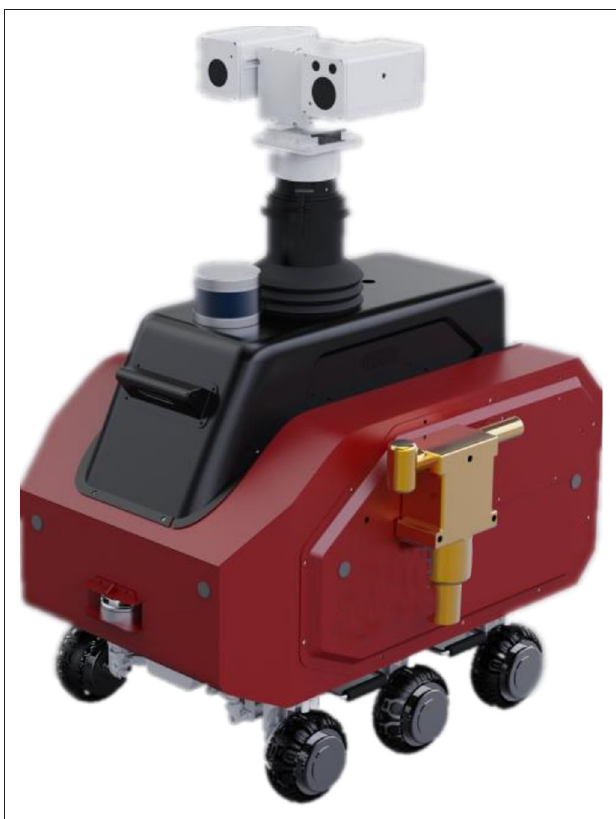
FIGURE 6 | The 6-wheeled robot.